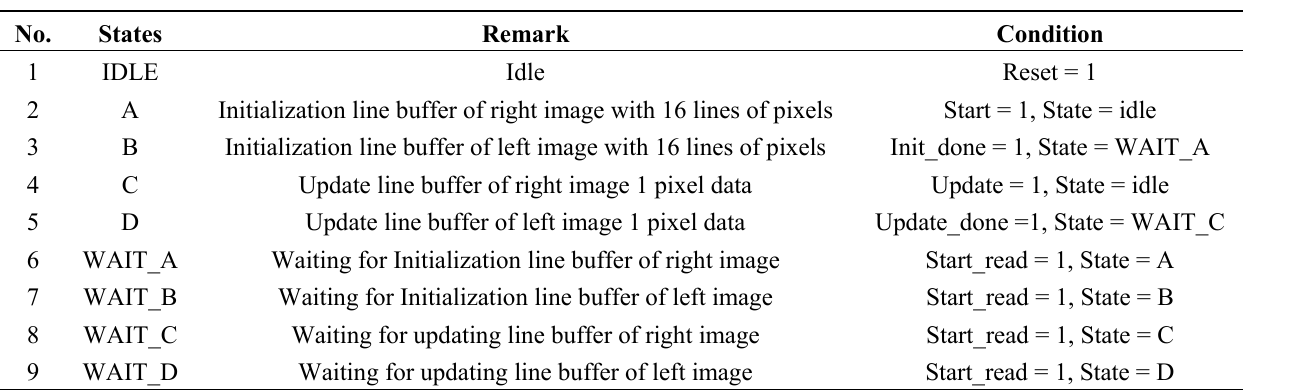
Table 1. List of